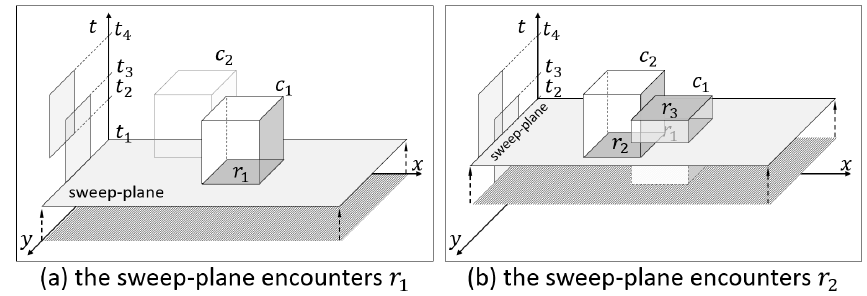
Figure 3. The plane sweep